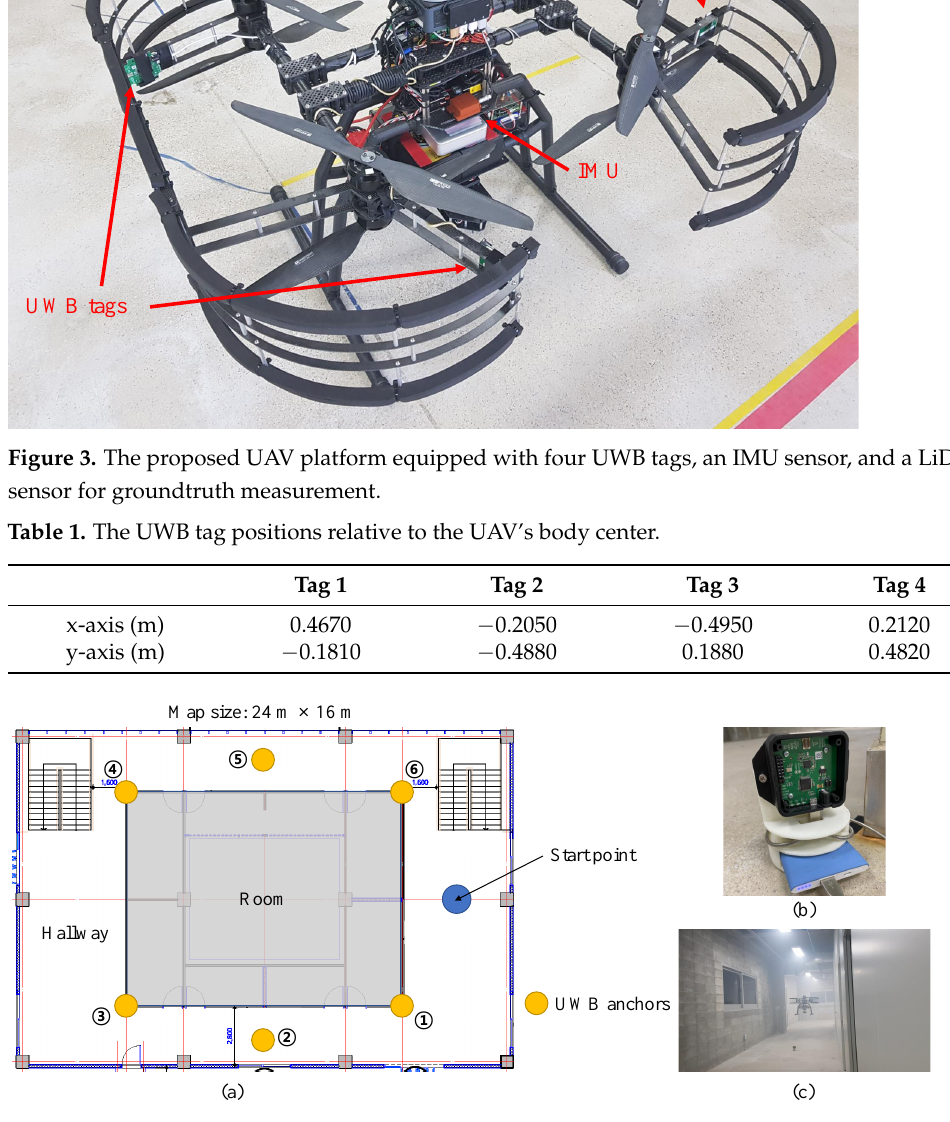
Figure 4. ( a ) The floor plan of the experimental site and the locations of UWB anchors. ( b ) The mount for the UWB anchor. ( c ) The scene of the real-flight